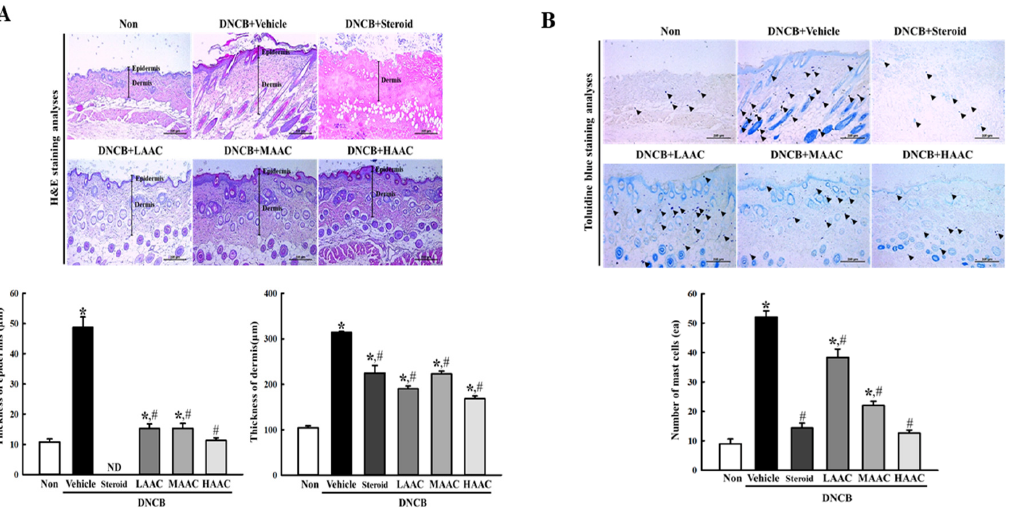
Figure 9. Histopathological structure of the skin in DNCB-treated BALB/c mice spread with AAC. ( A ) Alteration of skin histological structure. After staining with H&E solution, their structures were observed at 400× magnification using an optical microscope. The thickness of the epidermis and dermis was measured by Image J program. ( B ) Infiltration of mast cells. After staining with TB, the number of mast cells was calculated by observation at 400× magnification. Arrowheads indicate the infiltrated mast cells in the skin tissue. The H&E and TB-stained slides were prepared from four to six mice per group, and the histopathological parameters were analyzed in duplicate. All values in the results are represented as the means ± standard deviation (SD). * indicates statically significance compared to the non-treated group, while # indicates statistical significance compared to the DNCB+Vehicle-treated group. Abbreviations: AA, abietic acid; DNCB, 2,4-dinitrochlorobenzene; LAAC, low concentration of AA cream; MAAC, medium concentration of AA cream; HAAC, high concentration of AA cream; H&E, hematoxylin and eosin; TB, toluidine blue; ND, not